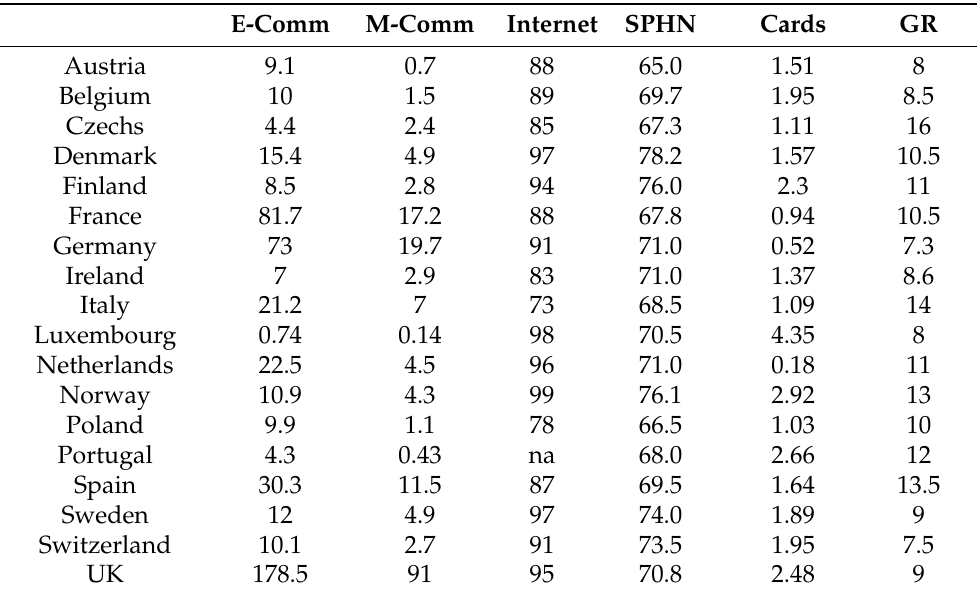
Table 4. E-commerce payments trends in European